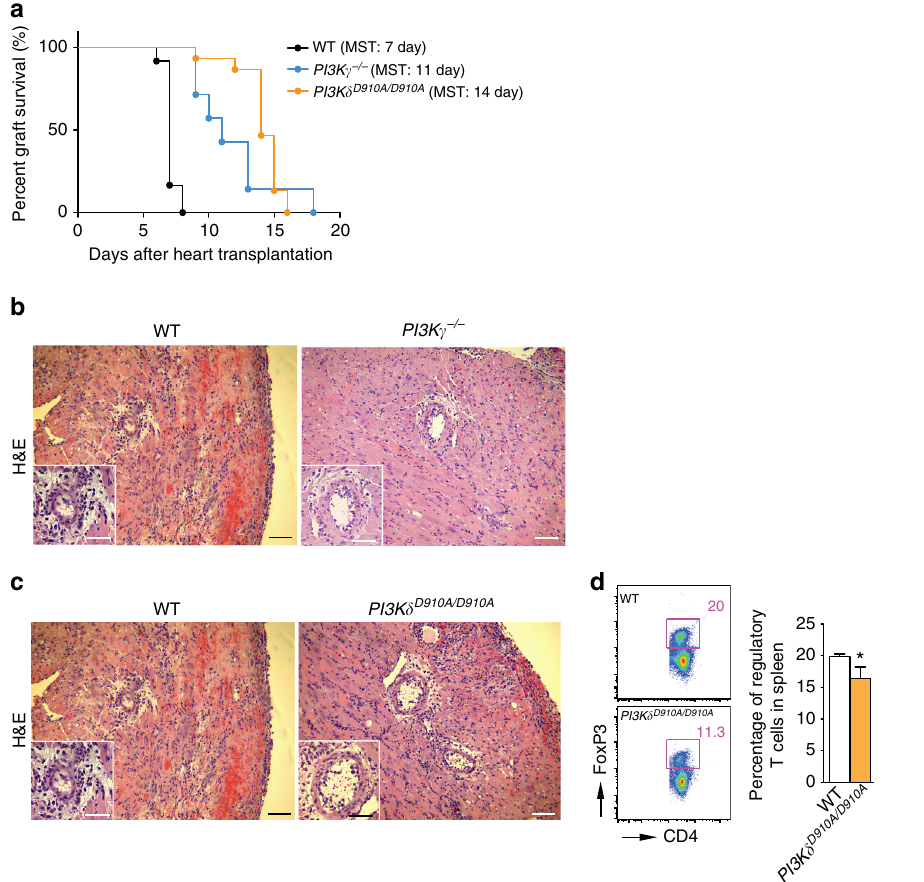
Fig. 2 PI3K γ or PI3K δ inhibition suppresses acute rejection. Naive BALB/c heart allografts were transplanted into fully allogeneic C57BL/6 (WT), PI3K γ − / − , or PI3K δ D910A/D910A recipients. a PI3K γ − / − recipients exhibited prolonged allograft survival compared to WT recipients (MST of 11 vs. 7 days respectively, * p < 0.05, t -test, n = 10/group). PI3K δ D910A/D910A recipients of BALB/c hearts showed signi fi cant prolongation of heart allograft survival compared